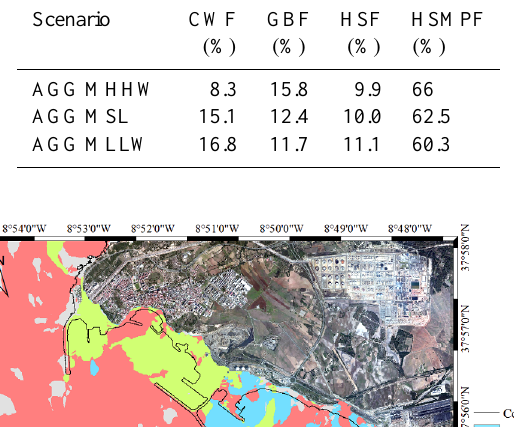
Table 3. Contribution of the scenarios considering MWH and MFD to the aggregate model at the three stages of the tide.